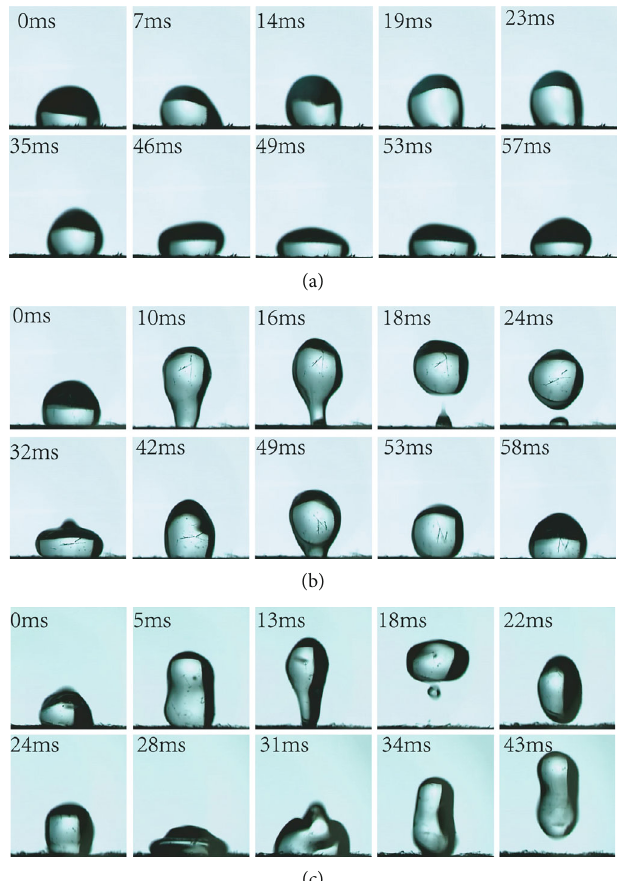
Figure 5: Under the vertical vibration amplitude of 2 mm, di ff erent frequency conditions, the movement of droplets on the surface of